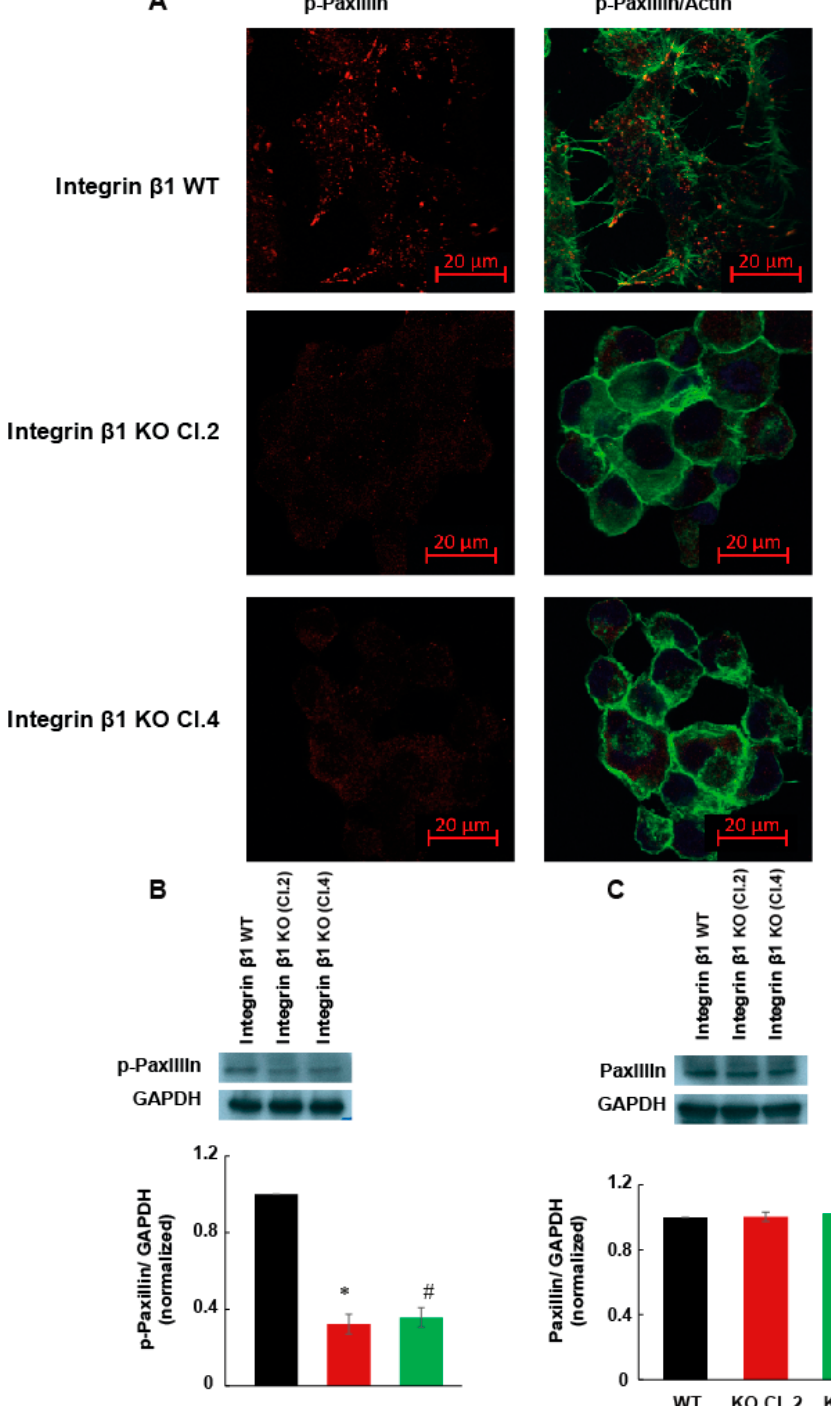
Figure 5. Impaired focal adhesion contributes to less cell spreading in MIA PaCa-2 integrin β 1 KO cells ( A ) Phospho-paxillin immunostaining shows the decrease in the phosphorylation status of paxillin in MIA PaCa-2 and integrin β 1 KO cells. Visualized by immunostaining F-actin, phalloidin, green, p-paxillin, Alexa flour 555, red). Scale bar 20 µm. ( B ) Immunoblotting confirmed the downregulation of p-paxillin. Normalized p-paxillin expression with GAPDH shows a significant decrease in expression of p-paxillin. ( C ) No significant change in paxillin expression normalized with GAPDH between WT and clones. One-way ANOVA was performed by Bonferroni’s test to compare between groups ( n = 3) * indicates a statistically significant difference between groups (integrin β 1 expressing MIA PaCa-2 and integrin β 1 KO cells Clone 2, p < 0.001). # Shows a statistically significant difference between groups (integrin β 1 expressing MIA PaCa-2 and integrin β 1 KO cells Clone 4, p < 0.001).